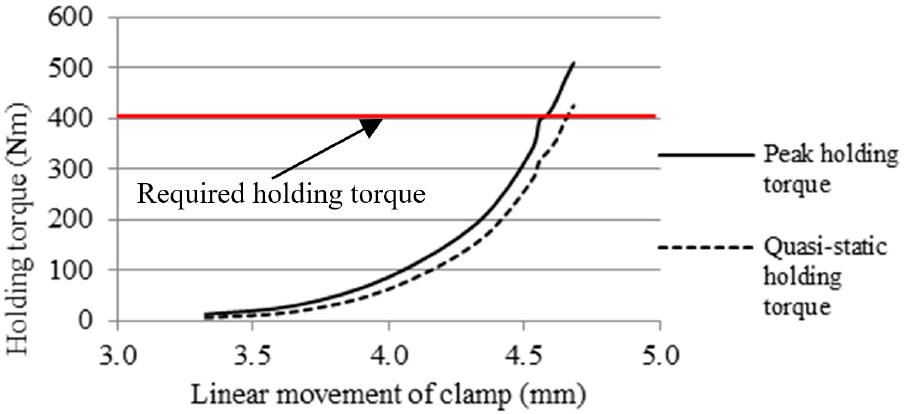
Figure 18. Overall results showing the holding torque with increasing clamping motion.